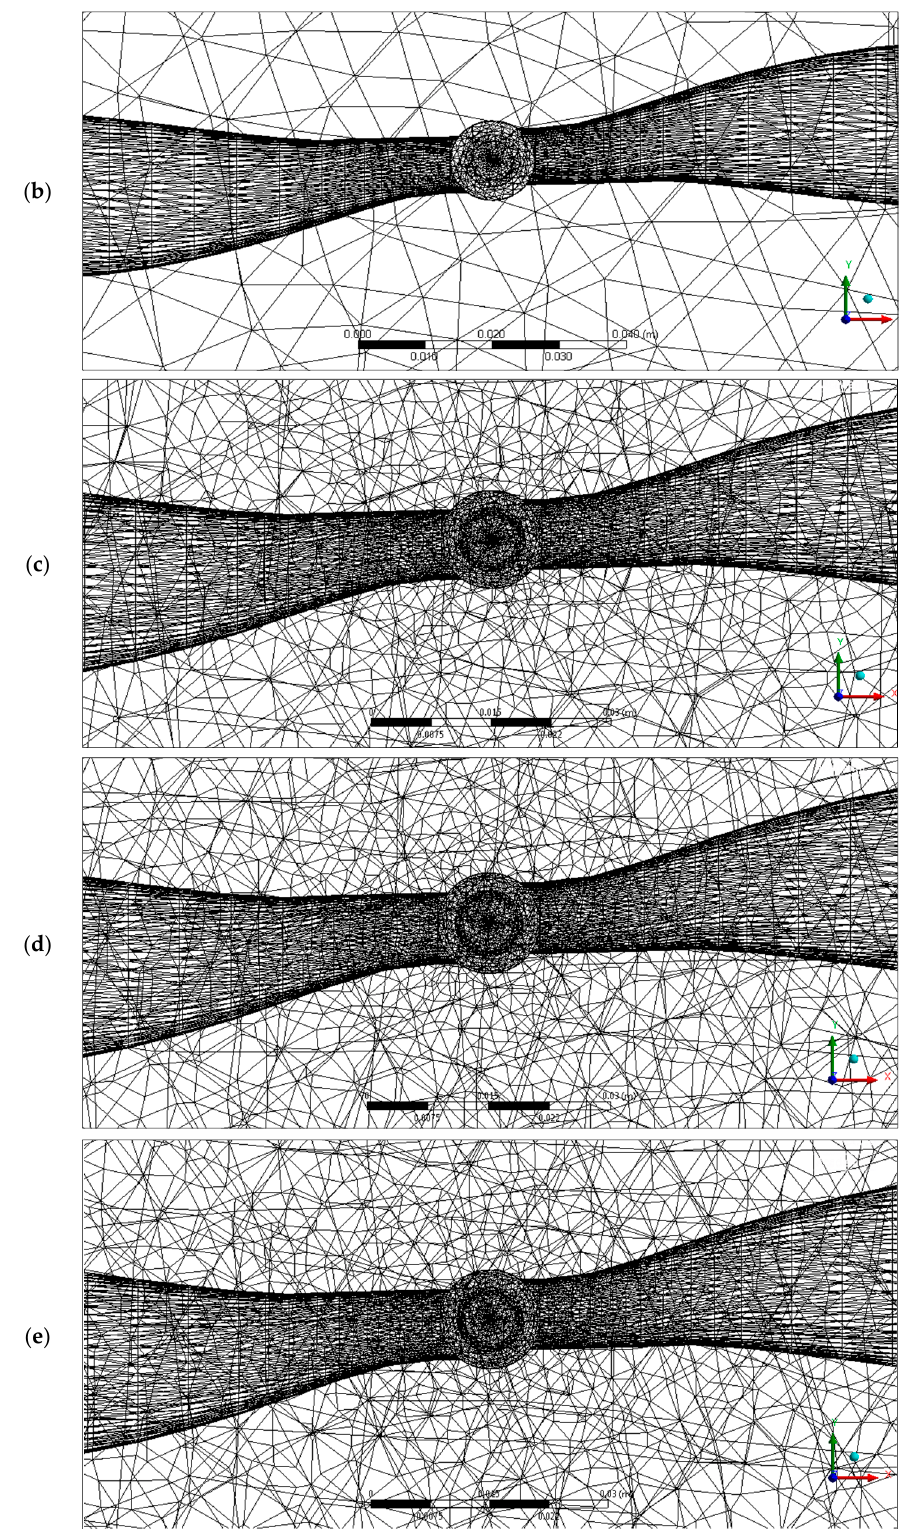
Figure 3. Surface mesh of the propeller blade. The cells sizes near the blade wall are smaller and increase towards the outer boundary. ( a ) Standard mesh; ( b ) Coarse mesh; ( c ) Mid mesh; ( d ) Mid-Fine mesh; ( e ) Fine mesh.